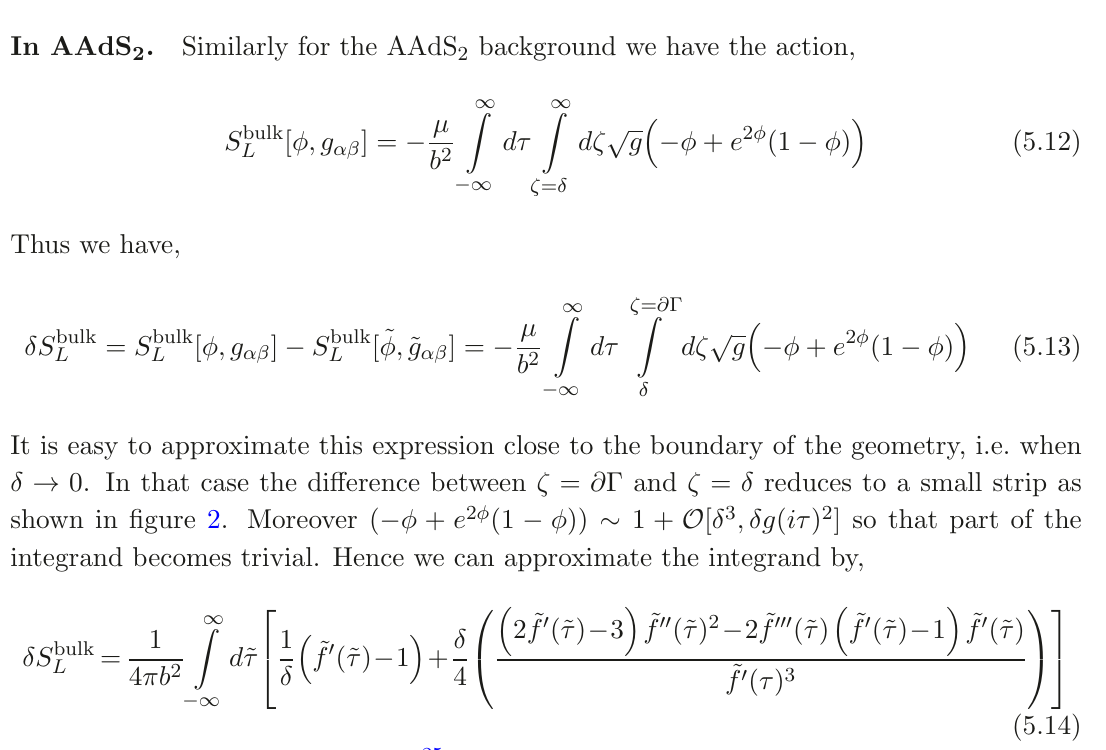
Figure 2 . The difference in bulk action between AdS 2 and AAdS 2 geometries gets contribution only from the shaded